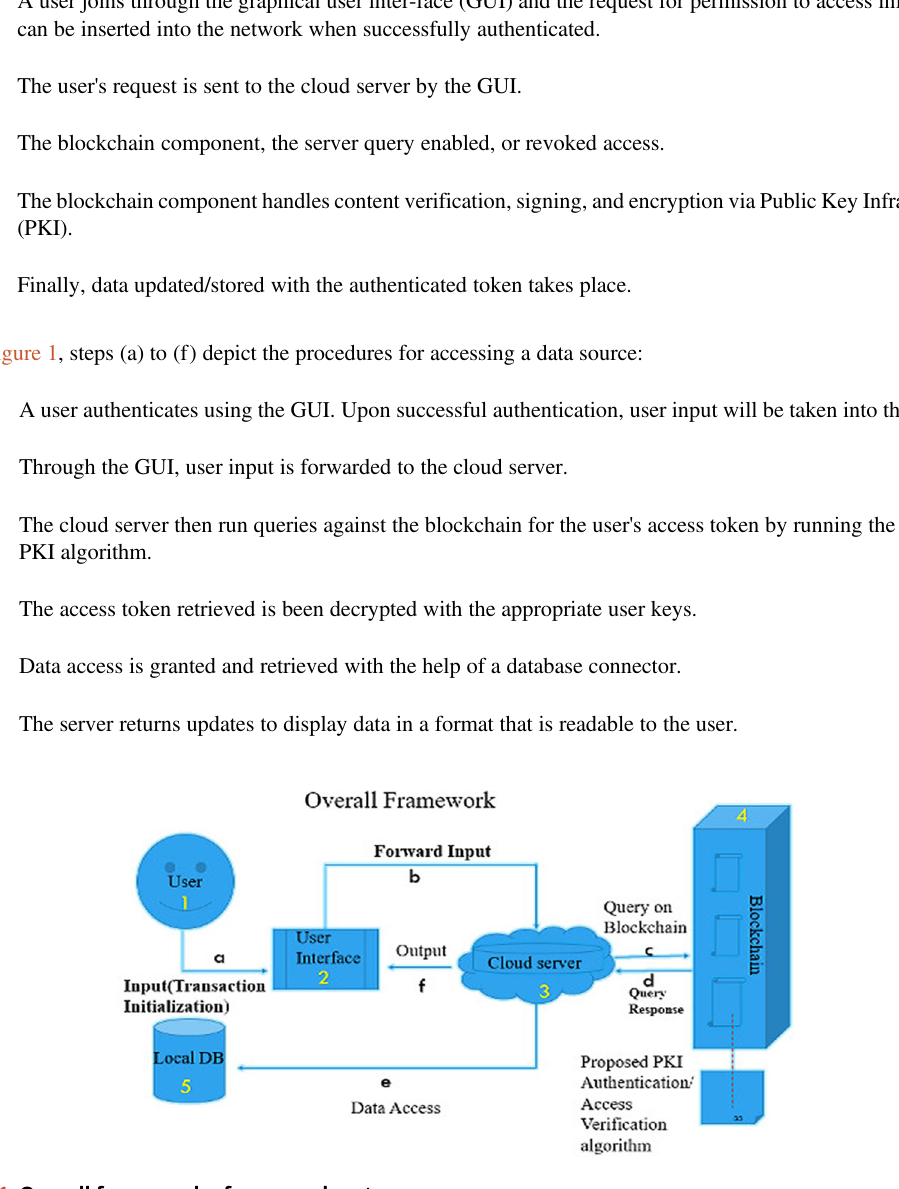
Figure 1. Overall framework of proposed